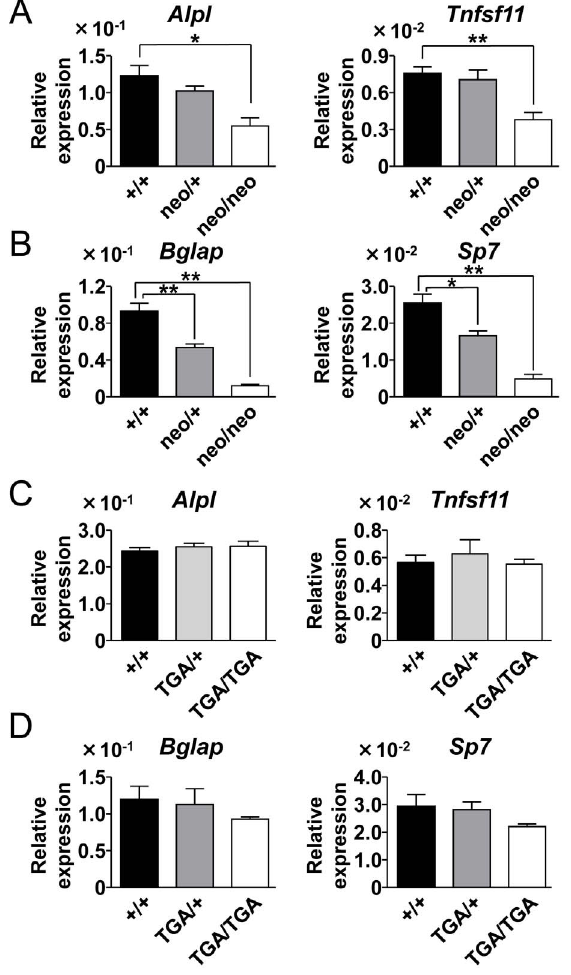
Figure 7. Osteoblastic gene expression was diminished in Runx2-I neo/neo calvarial cells. Expression of the indicated osteoblastic genes in calvarial cells (A and C) and osteoblast differentiated cells (B and D) from Runx2-I -mutated (A and B; + / + , neo/ + , neo/neo, C and D; + / + , TGA/ + , TGA/TGA). Quantitative real-time PCR analysis was performed by using the same RNA used for the analyses shown in Figure 3A ( neo -possessing mice) and Figure 4D ( neo -deleted mice). Data are representative of three independent experiments and are means 6 SEM ( n =3/group); * p , 0.05, ** p , 0.01.